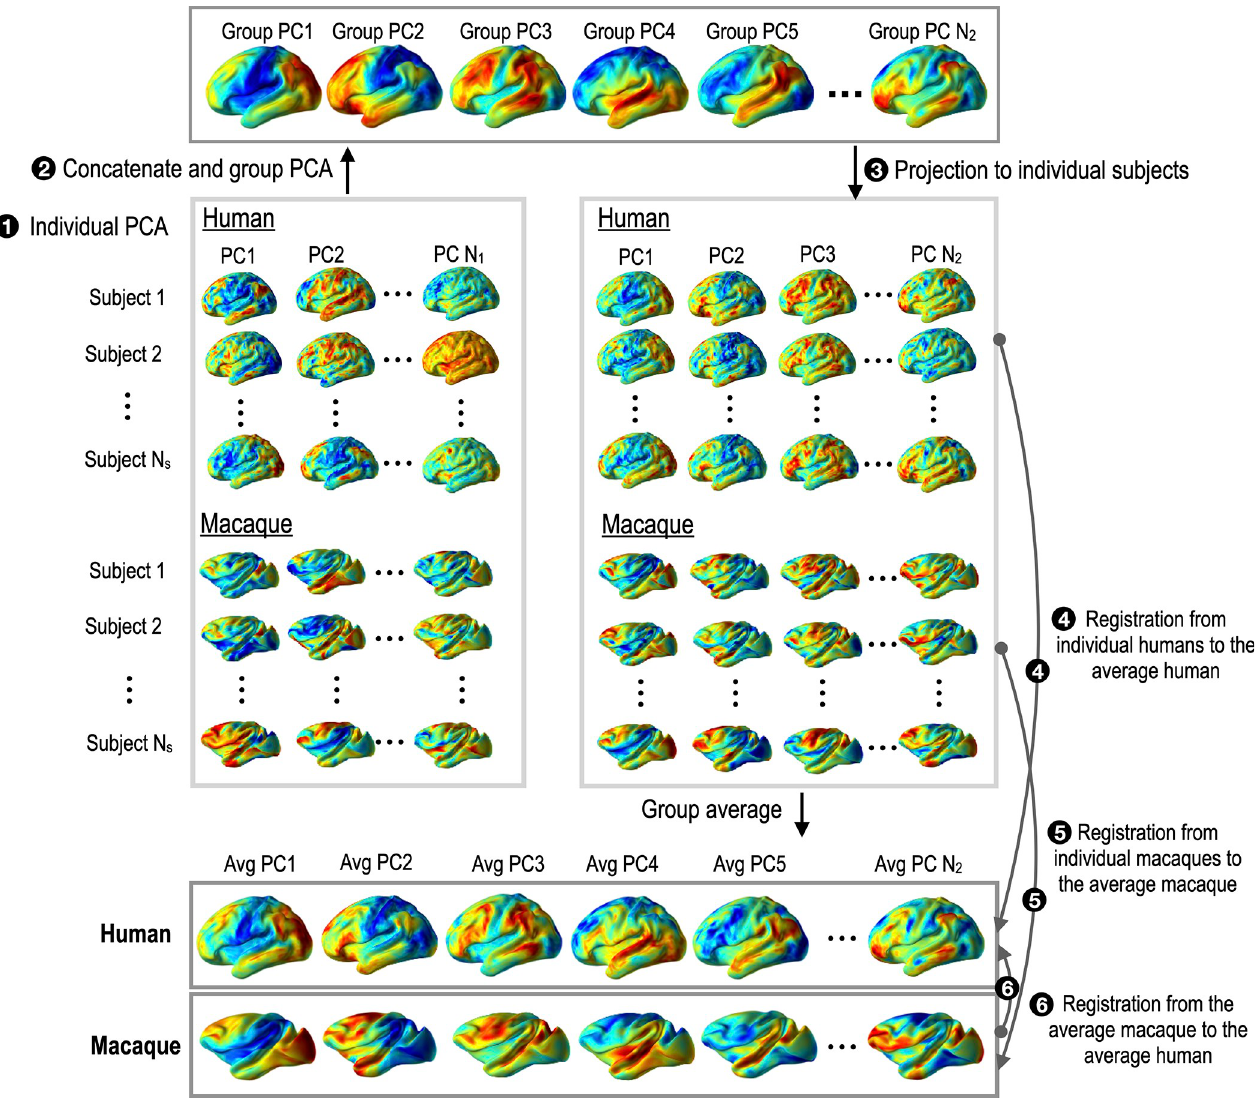
Fig 2. Group PCA procedure of extracting individual principal components (PCs) corresponding to each other and across species as functional connectivity modes. PCA of individual subjects’ PCs was conducted to find group-common PCs in humans and macaques. Those group-common PCs were projected to each individual. These PCs are driven from N x R functional connectivity matrices, not from conventional fMRI time series. From the individual PCs, group-average PCs for humans and macaques were generated. To these group-average PCs, spherical registration of each individual was conducted.